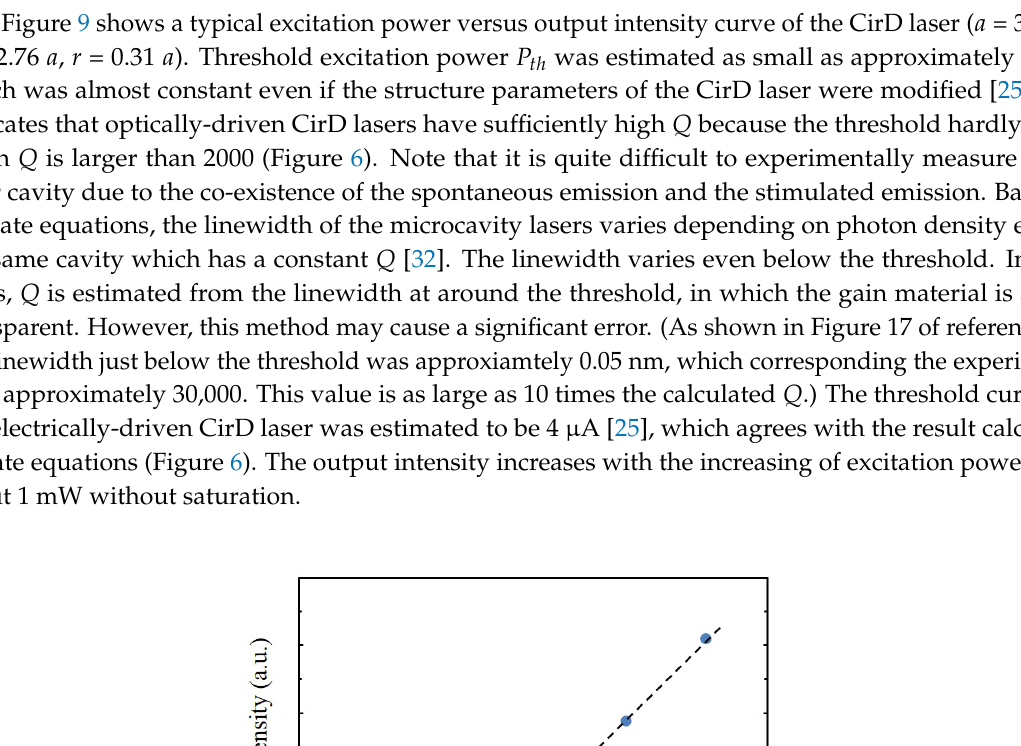
Figure 8. ( a ) Top-view and ( b ) cross-sectional view of SEM pictures for fabricated optically-driven CirD laser.